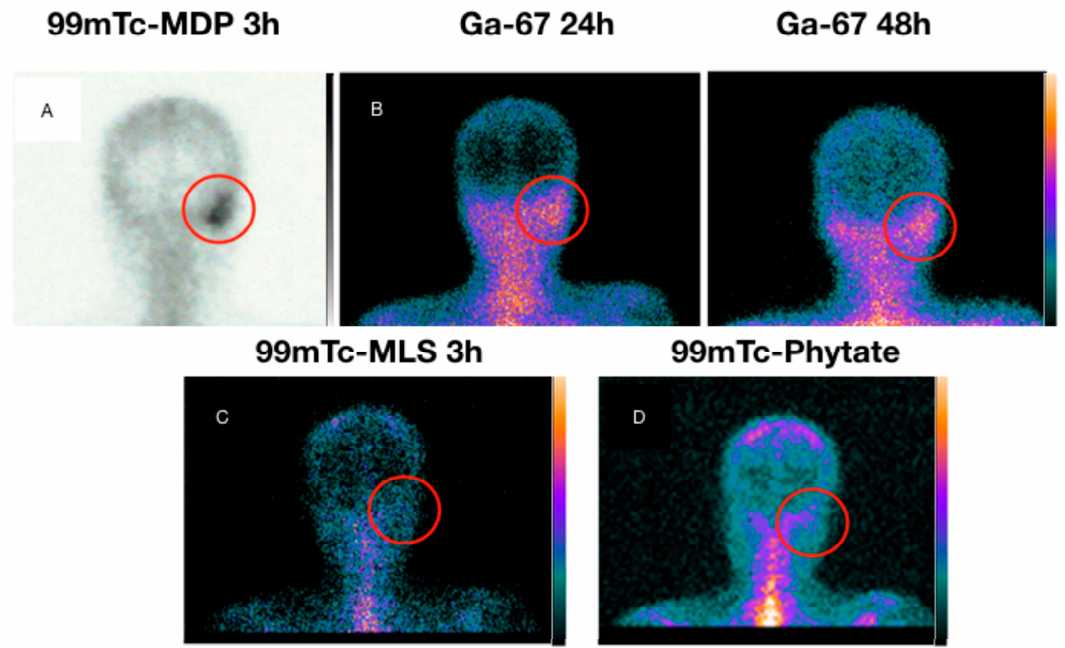
Figure 4. Patient 19. Male patient, 38 years old, DM insulin-dependent, with right otalgia and refractory otorrhoea at the beginning of treatment. Otoscopy revealed small erosion in the posterior EAM, which is associated with granulation tissue and pus. Culture analysis results revealed Proteus mirabilis ciprofloxacin sensitivity. Acquired images in anteroposterior incidence. ( A ) Bone 99m Tc-MDP scintigraphy in right mastoid topography (ROI, red ring). ( B ) 67 Ga scintigraphy in 24 h and 48 h after iv radiotracer injection, which shows persistent uptake. ( C ) 99m Tc-MLS was inconsistent with the infection hypothesis. ( D ) 99m Tc-phytate scintigraphy showing uptake at ROI. Histopathology revealed a cholesteatoma in EAM.